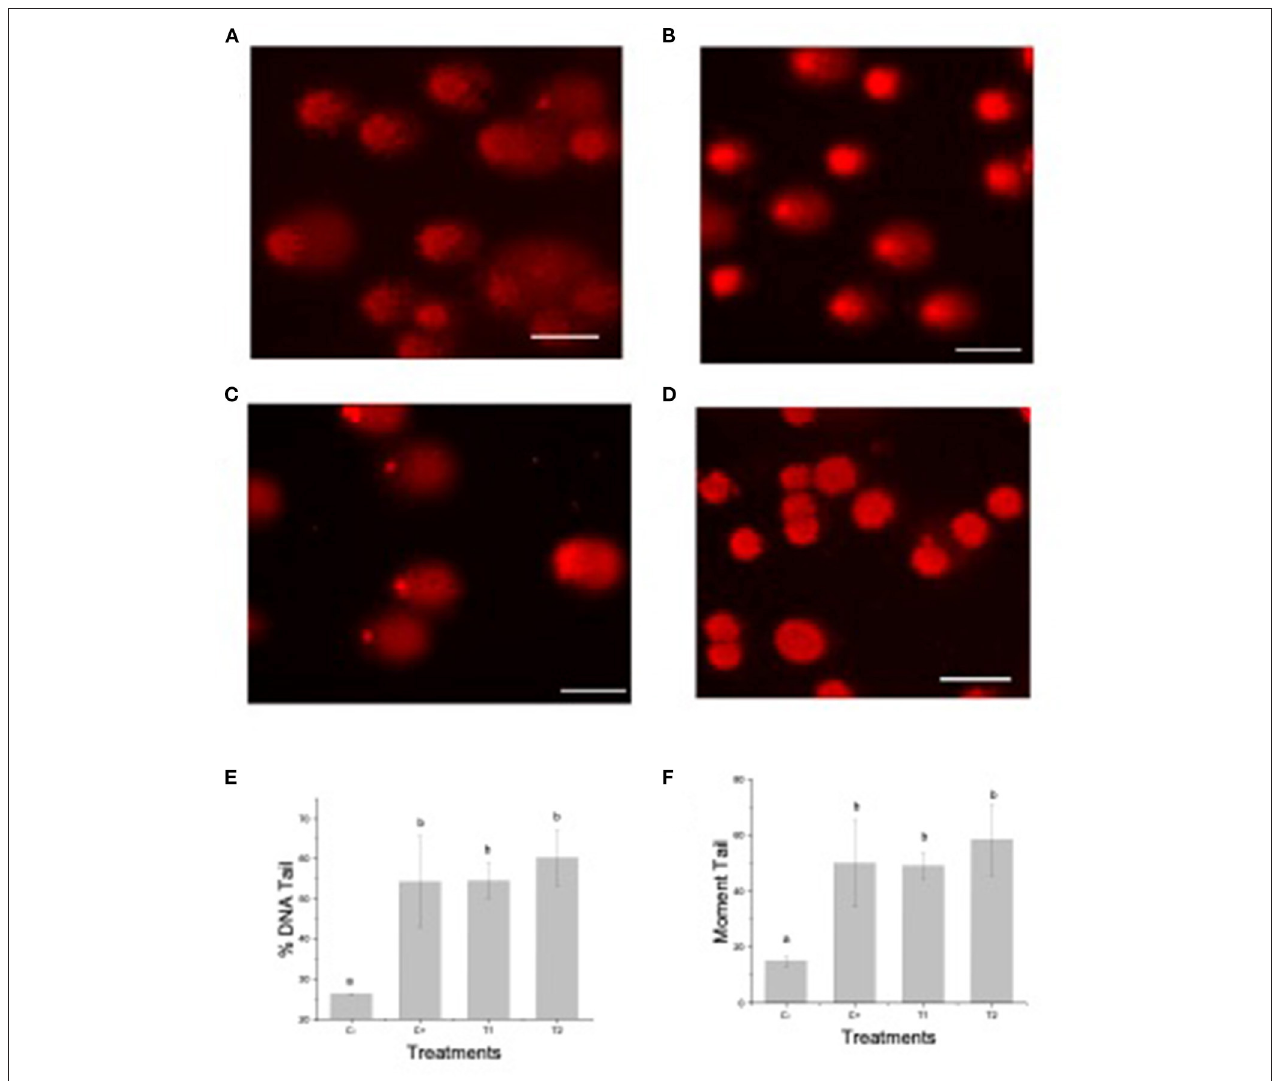
FIGURE 3 | Ex vivo testing of Oreochromis niloticus erythrocytes by the comet assay. (A) Caesalpinia spinosa 5.0 mg/ml. (B) C. spinosa 2.5 mg/ml. (C) Positive control (cyclophosphamide 1.25 µ g/ml). (D) Negative control. Bar 50 µ m. (E) %DNA Tail and (F) Moment Tail (C- Negative control; C + Positive control; T1 and T2, C. spinosa 2.5 and 5.0 mg/ml, respectively). Same letters mean no significant